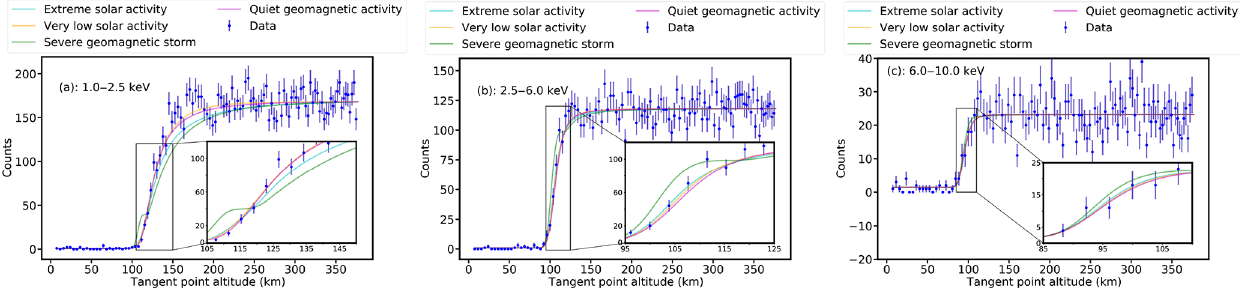
Figure 13. Comparison of the observed data and forward model light curves under extreme solar activity, very low solar activity, severe geomagnetic storm, and quiet geomagnetic activity. The NRLMSISE-00 density profiles are used as input data for those simulations. For clarity, the data points are displayed by taking one point every five points from the initial data points. The energy range of the light curves in panel (a) , (b) , and (c) is 1–2.5, 2.5–6.0, and 6.0–10.0keV, respectively. Furthermore, local magnification of the light curves in the altitude range of 105–150, 95–125, and 85–110km is carried out to show the influence of solar and geomagnetic activities on the shape of the model light curves in panel (a) , (b) , and (c) , respectively. Table 5. The calculated values of AIC, BIC, χ 2 / dof, and p value. Energy Model AIC